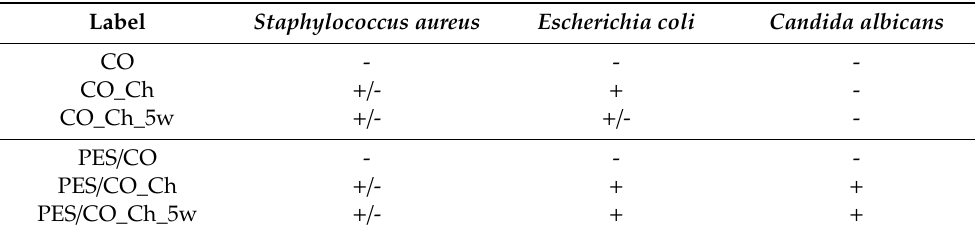
Table 4. The results of antimicrobial activity of selected CO and PES / CO fabrics.